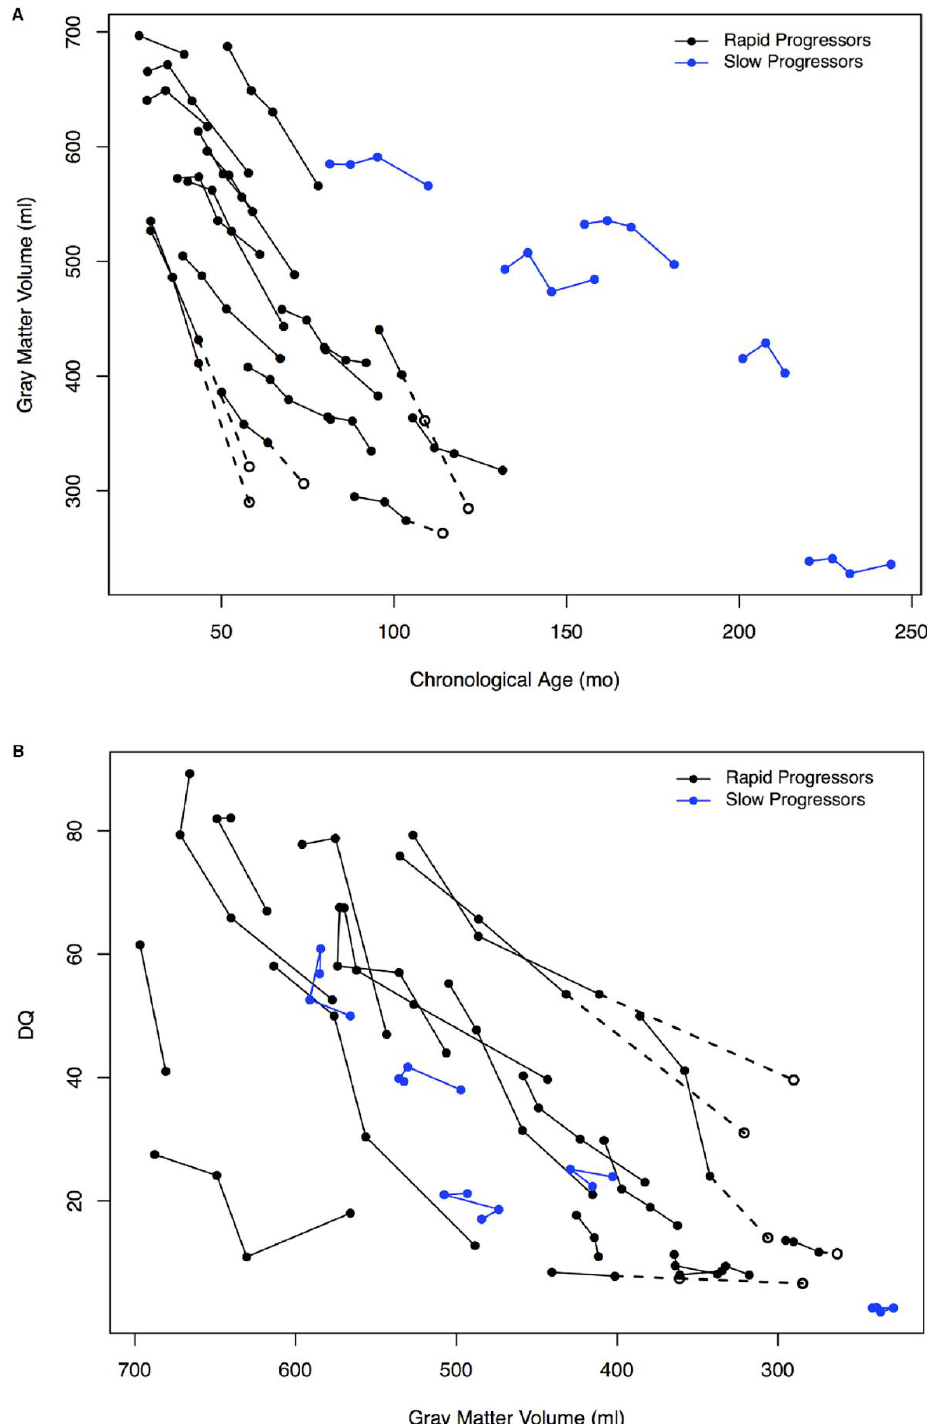
Figure 1. Association of grey matter volume and developmental quotient (DQ). A , Change in gray matter volume for the rapid progressing (RP) and slow progressing (SP) groups of MPS IIIA patients by age. B , Association of decline in developmental quotient and gray matter volume for the RP and SP groups. Open circles indicate the imputed values, which are connected with dotted lines (values imputed from slope of previous visits) for 4 patients at the 24-month visit only and for 1 patient at both the 12-month and 24-month visits (figure reproduced from Shapiro et al., 2016 [37], with permission from Elsevier).